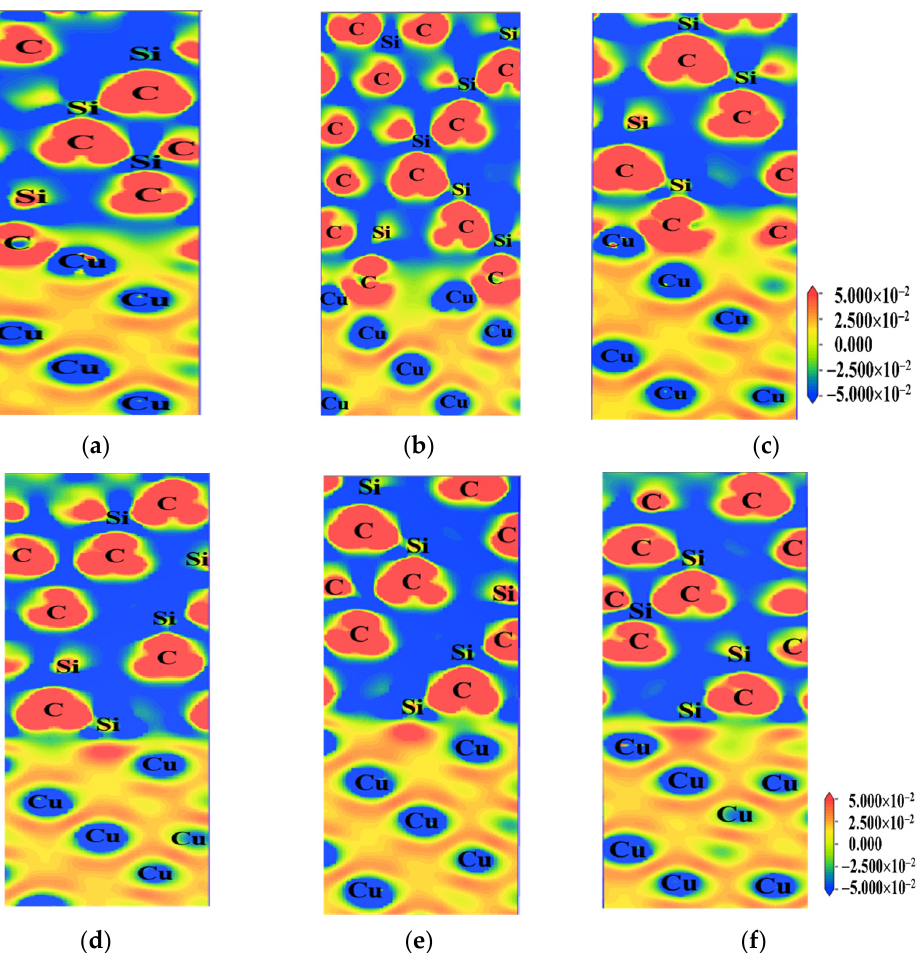
Figure 6. Charge density difference of the interfacial atoms of all “(a)” types of 6H-SiC(0001)/Cu(111) interfacial models along (211) interface (eV/Å 3 ). ( a ) CT-HCP(a); ( b ) CT-MT(a); ( c ) CT-OT(a); ( d ) ST-HCP(a); ( e ) ST-MT(a); ( f ) ST-OT(a).